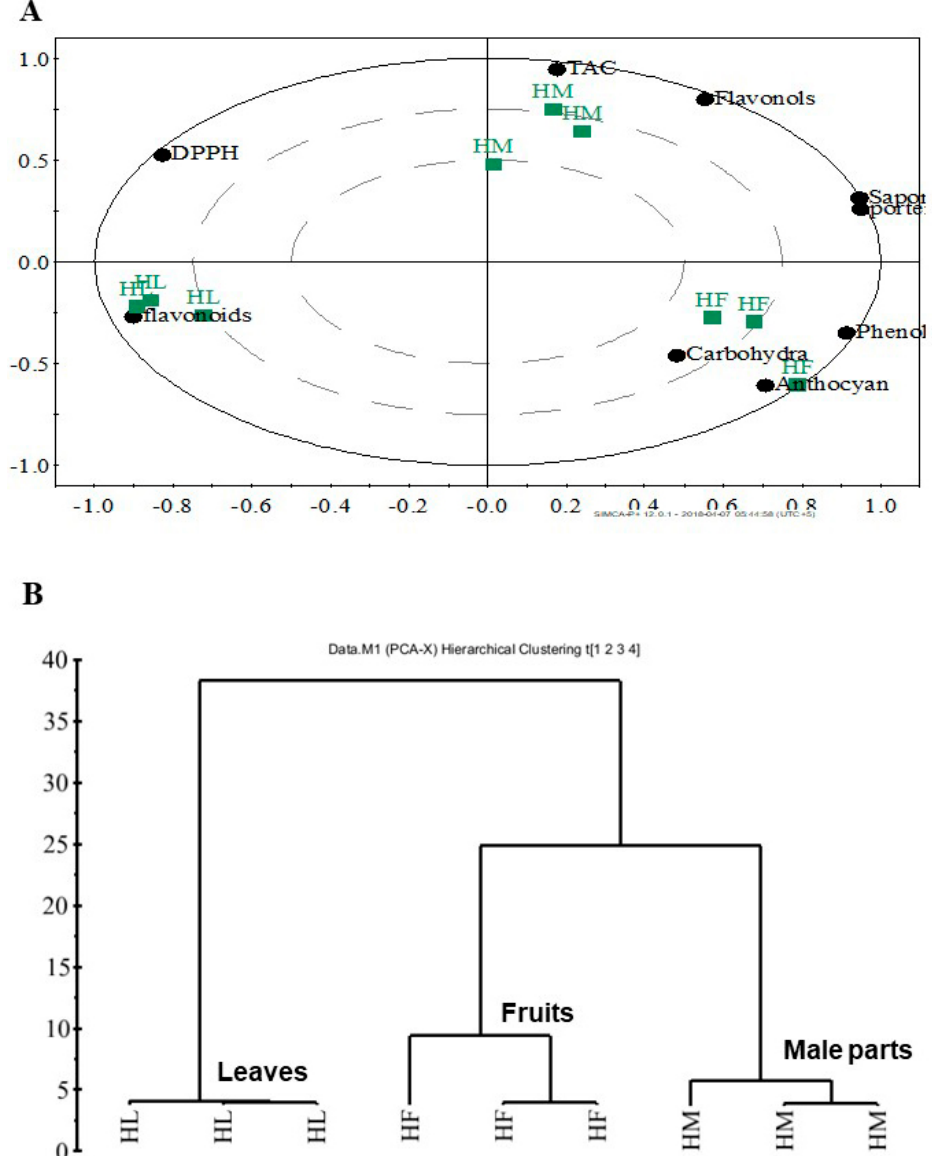
Figure 2. Score biplot of PC1 versus PC2 ( A ), and hierarchal clustering analysis (HCA) ( B ) of the metabolomic profiling of different parts of H. thebaica . HL = doum palm leaves, HM = doum palm male parts and HF = doum palm fruits.